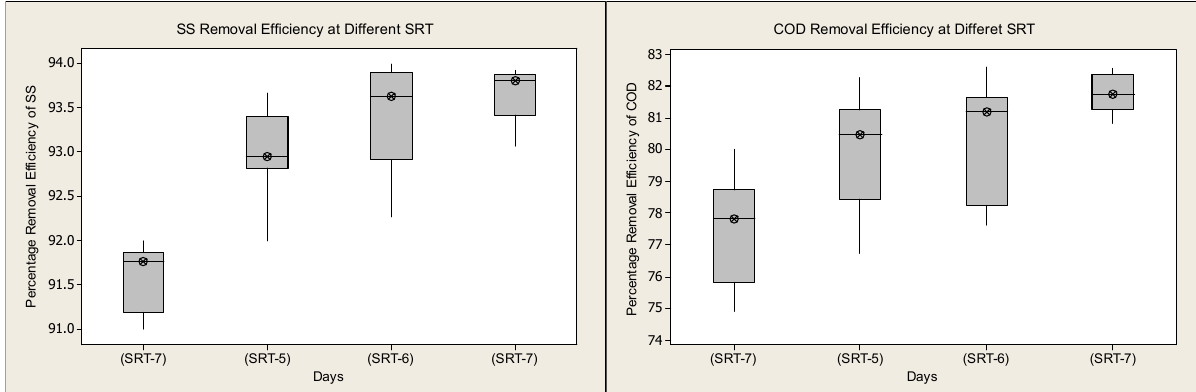
Figure 2. Effluent concentrations at different SRTs.